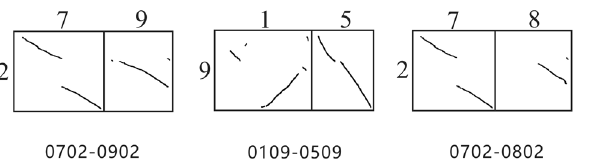
Figure 5. Search results for chromosome rearrangement patterns in the Oryza sativa and Sorghum bicolo